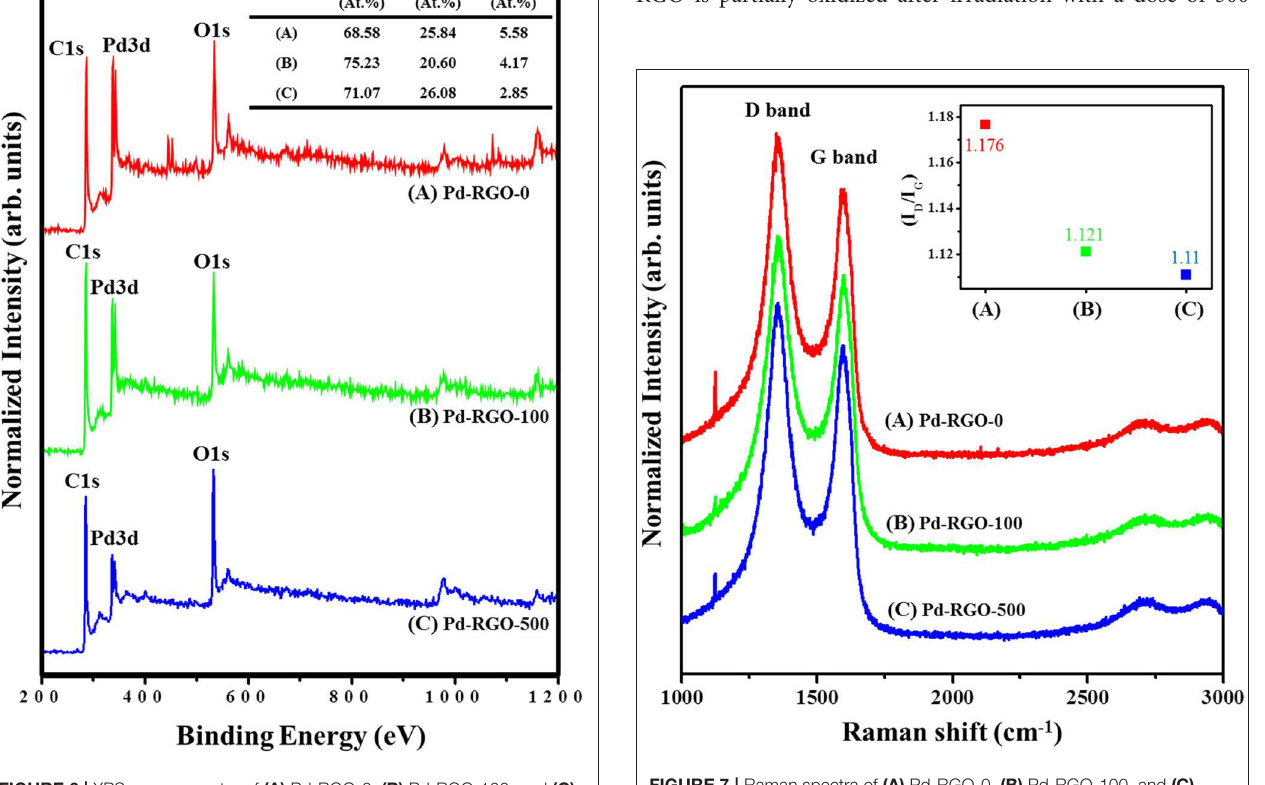
FIGURE 6 | XPS survey spectra of (A) Pd-RGO-0, (B) Pd-RGO-100, and (C) Pd-RGO-500.